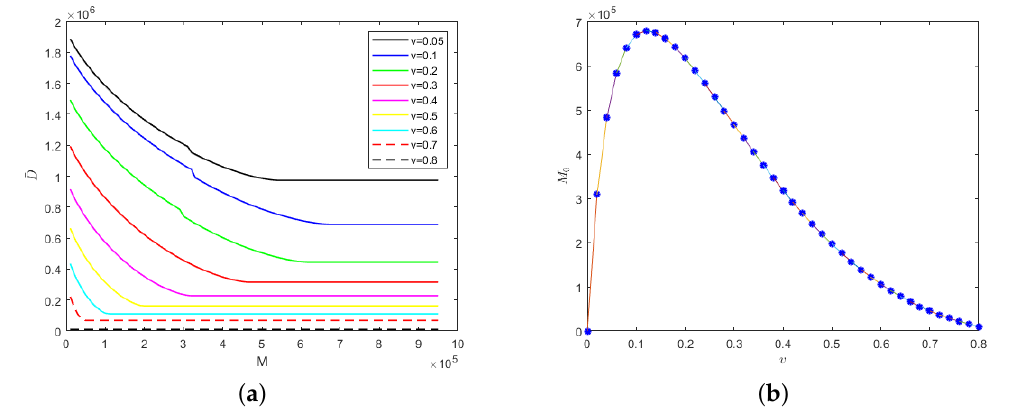
Figure 4. With the fixed parameter k = 5: ( a ) evolution results of the number of deaths according to medical resources at the different isolation rates of hospitalized individuals; ( b ) evolution results of safe medical resources according to those isolation